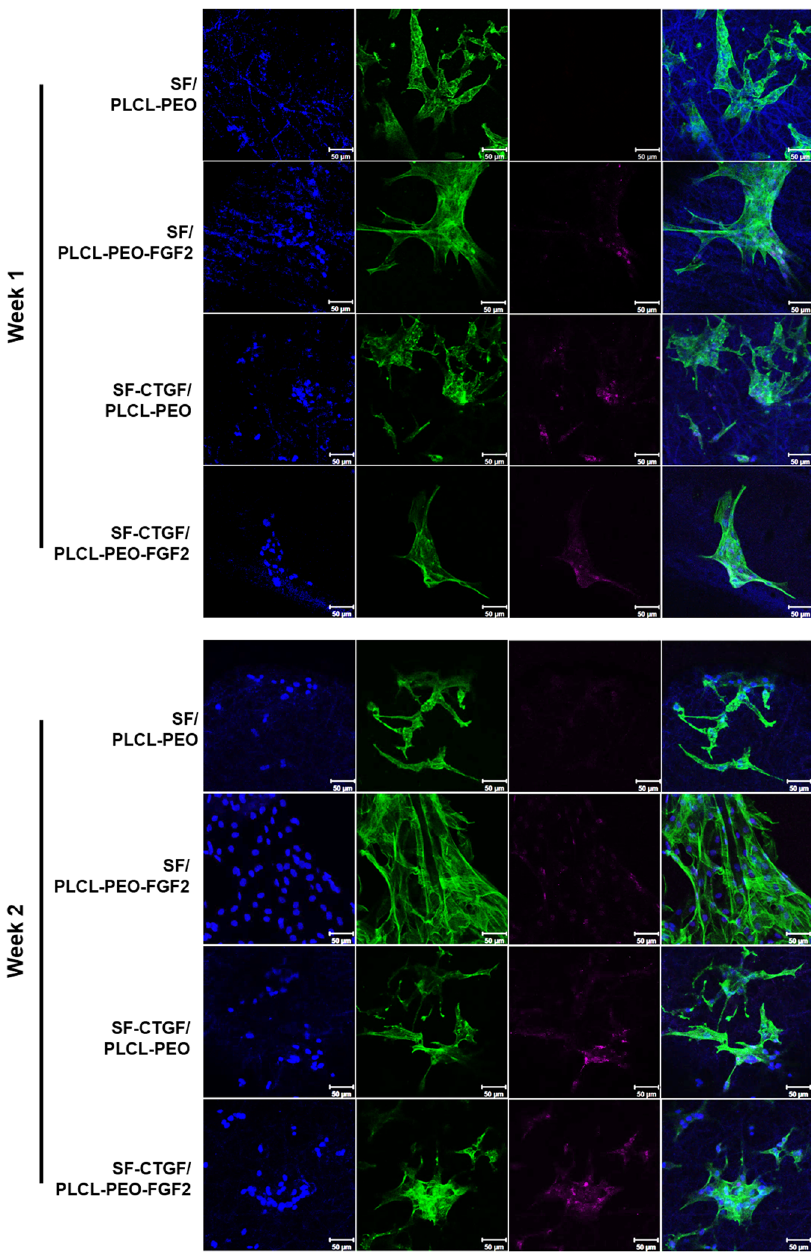
Figure 6. Immunofluorescence of fibroblastic differentiation for rMSCs on different coaxial nanofibrous scaffolds. ( A ) After 1 week culture on different scaffolds. ( B ) After 2 week culture on different scaffolds. Cells were stained for nuclei (blue), F-actin (green) and FSP1